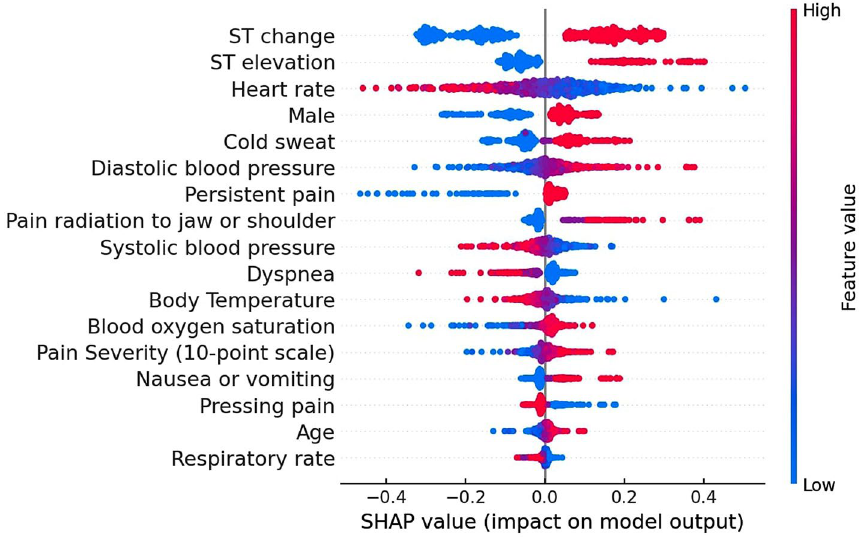
Figure 3. SHAP values of the prehospital diagnostic algorithm for acute coronary syndrome using 17 features. The impact of the features on the model output was expressed as the SHAP value calculated with the support vector machine (radial basis function). The features are placed in descending order according to their importance. The association between the feature value and SHAP value indicates a positive or negative impact of the predictors. The extent of the value is depicted as red (high) or blue (low) plots. SHAP (SHapley Additive